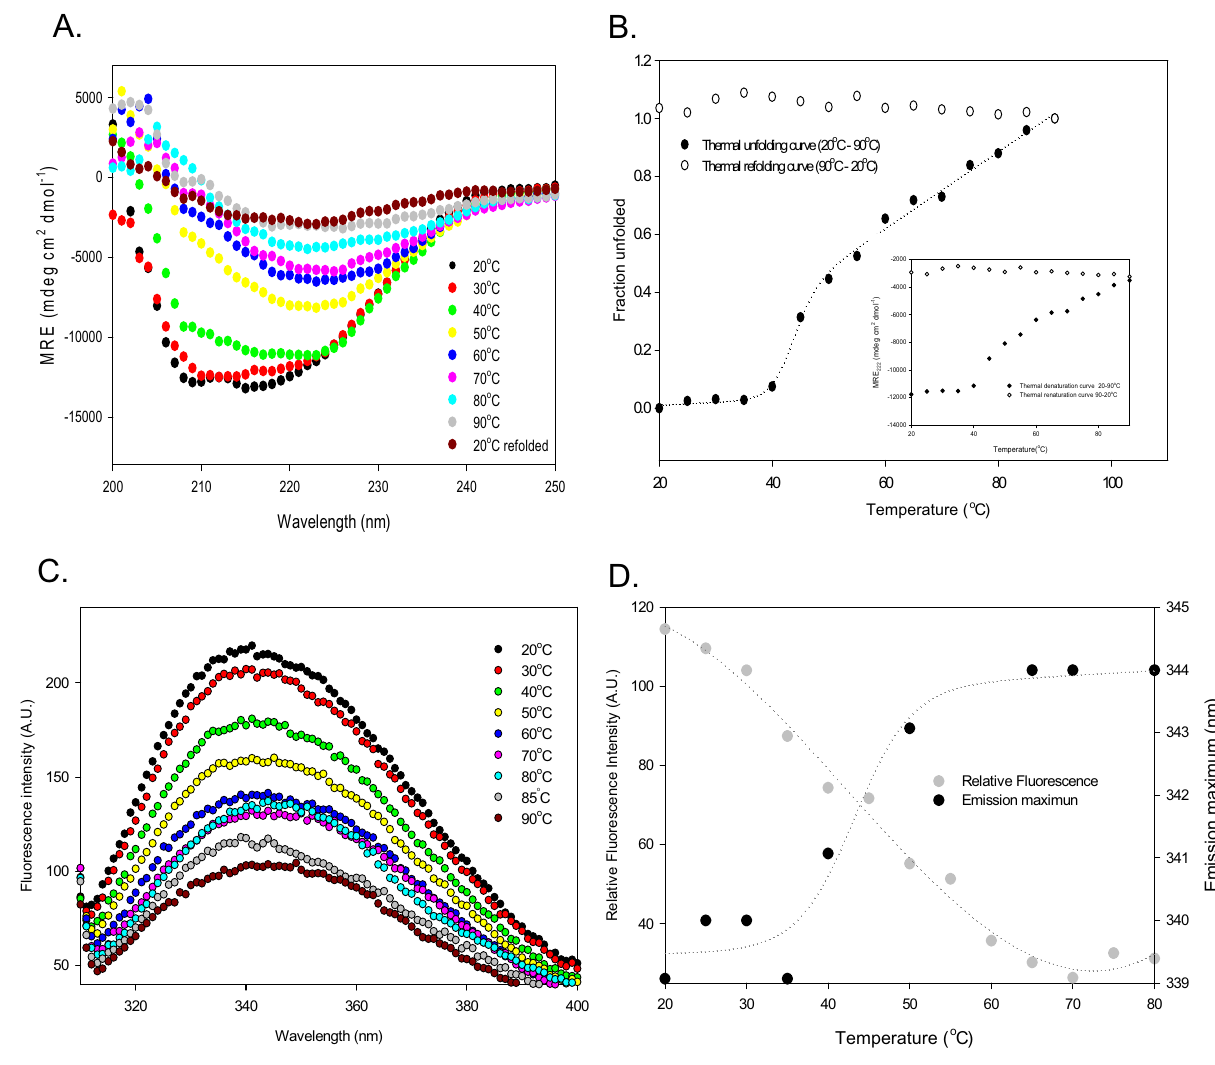
Figure 6. Thermal unfolding and refolding profile of AAR. Upper panel represents thermal unfolding and refolding probed by CD spectroscopy. ( A ) Graph shows CD spectra of AAR (3.5 µM) when subjected to different temperatures varying from 20 to 90 °C. ( B ) Graph represents thermal unfolding (20–90 °C) and refolding transition (90–20 °C) curve of AAR monitored by CD spectroscopy at 222 nm. The intercept and slope of baselines, of the unfolding transition curve, were used for fitting data in two state model represented by dotted line. The inset of graph represents the MRE 222 values of AAR protein corresponding to different temperatures during thermal unfolding and refolding transition. Lower panel represents thermal unfolding and refolding probed by intrinsic fluorescence spectroscopy. ( C ) Graph represents unfolding of AAR subjected to different temperatures from 20 to 90 °C. Fluorescence emission spectra of AAR monitored from 300 to 400 nm when excited at 295 nm at varying temperatures. Fluorescence intensity decreases with increase in temperature. ( D ) Graph represents the relative fluorescence intensity at 340 nm of AAR subjected to different temperatures (20–80 °C). The secondary axis plot shows the change in the emission maximum (λ max ) with increasing temperature. The intercept and slope of baselines, of the unfolding transition curve, were used for fitting of data in two state unfolding model.